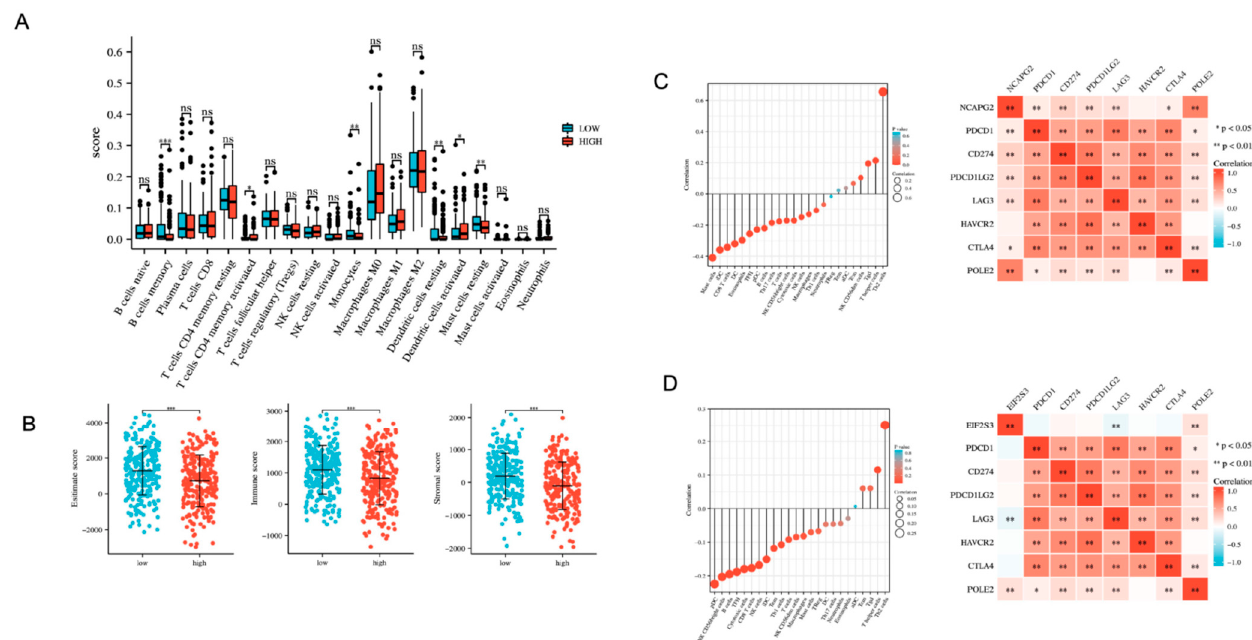
Figure 6. Immunoassay. ( A ) The relationship between high- and low-risk groups in the prognostic model and CIBERSORTx immune cell infiltration abundance. ( B ) The relationship between high- and low-risk groups and the immune score. ( C ) Correlation of NCAPG2 with immune cells and immune checkpoints. ( D ) Correlation of EIF2S3 with immune cells and immune checkpoints. *** p < 0.001, ** p < 0.01, * p < 0.05, ns: no significance.